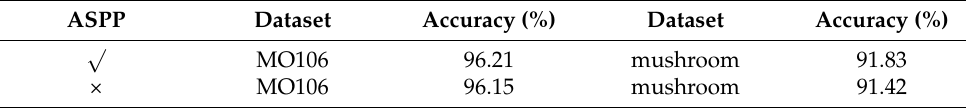
Table 6. Impact of the ASPP module on the model.